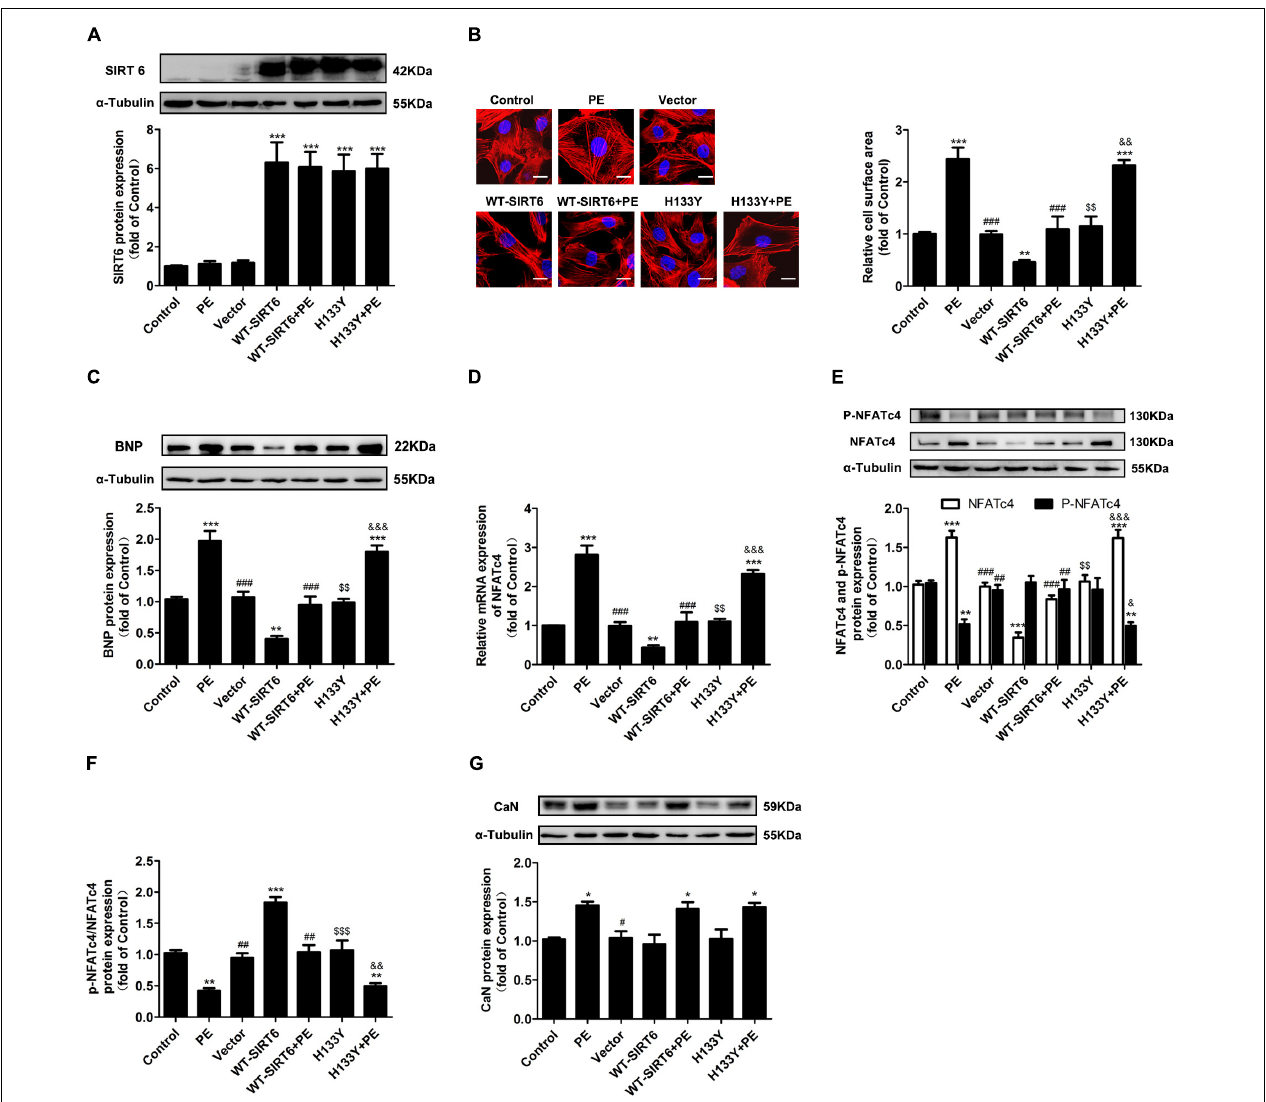
FIGURE 4 | The effects of SIRT6 were dependent on deacetylase activity. NRCMs were transiently transfected with plasmid encoding the WT-SIRT6 and mutant of SIRT6 (H133Y) for 48 h followed by incubation with PE (100 µ M for 12 h). (A) Western blot analysis was conducted to determine the protein expression of SIRT6. (B) The cell surface area was measured by rhodamine-phalloidin staining. Scale bar: 20 µ m. (C) Western blot analysis was conducted to determine the protein expressions of BNP. (D) The mRNA expression of NFATc4 was determined by qRT-PCR. (E) The protein expression of total NFATc4, phosphorylated NFATc4 was determined by Western blotting. (F) The ratio of p-NFATc4/NFATc4 was calculated. (G) The protein expression of calcineurin was studied in NRCMs treated with 100 µ M PE for 12 h. The data were presented as mean ± SEM. ∗ P < 0.05, ∗∗ P < 0.01, ∗∗∗ P < 0.001 vs. Control. # P < 0.05, ## P < 0.01, ### P < 0.001, vs. PE. $$ P < 0.01, $$$ P < 0.001, vs. WT-SIRT6. & P < 0.05, && P < 0.01, &&& P < 0.001, vs. WT-SIRT6 + PE. n =